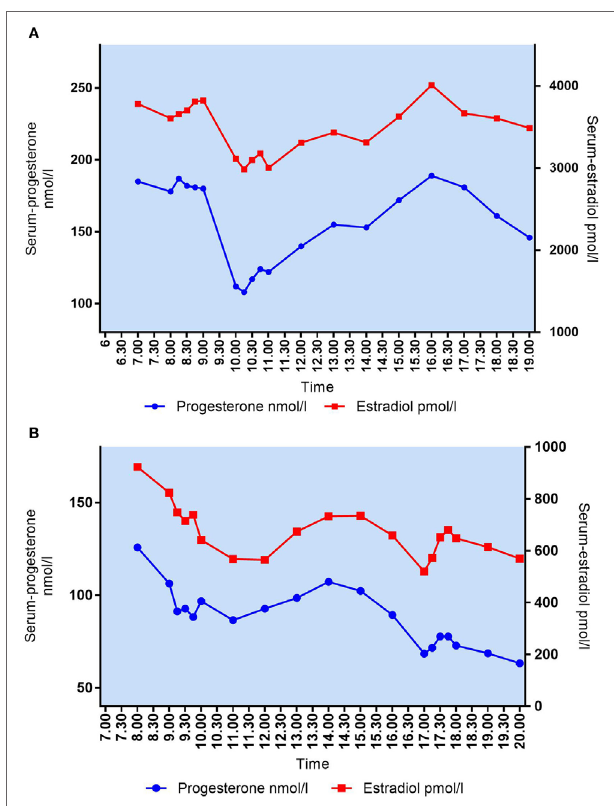
FigUre 5 | (a) Daytime variation in mid-luteal s-progesterone and s-estradiol in patient #10. Median P 4 = 161 nmol/l, median E 2 = 3,606 pmol/l. (b) Daytime variation in mid-luteal s-progesterone and s-estradiol in patient #1. Median P 4 = 89 nmol/l, median E 2 = 659